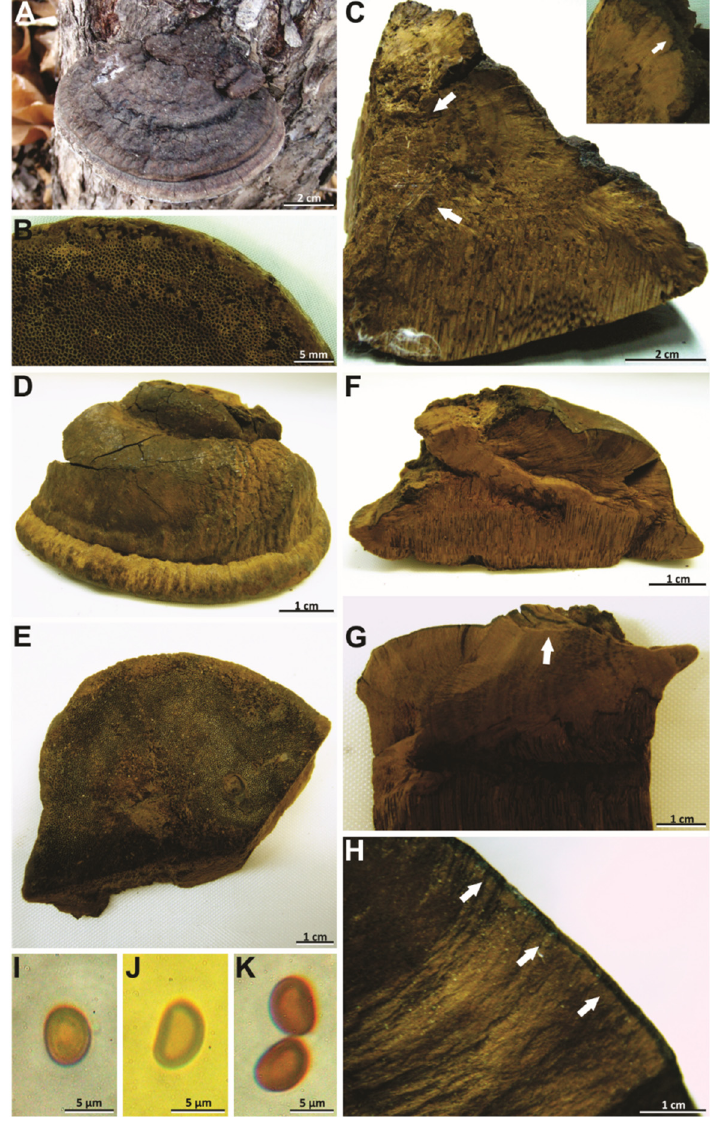
Figure 3. Morphological features of Phellinotus badius and P . magnoporatus . ( A – C ) P . magnoporatus (USM 250523, holotype). ( A ) basidioma; ( B ) pore surface; ( C ) perennial basidioma with detail of mycelial core in the context (the white arrows point to the cuticule and mycelial core in the context). ( D – K ) Phellinotus badius (K–M 199720, lectotype). ( D ) basidioma; ( E ) pore surface; ( F – H ) perennial basidioma with detail of a dark line in the context (the white arrows point to the dark line in the context); ( I – K ) basidiospores. ( I ) in water; ( J ) in Melzer’s reagent; ( K ) in KOH. Hyphal system monomitic in the context and dimitic in the tubes; context domi- nated by generative hyphae, (3–)4–5(–6.5) µ m diam, branched, thin-walled to gradually thick-walled, occasionally septate, trama of tubes with thin to slightly thick-walled gen- erative hyphae, simple septate, branched, and unbranched skeletal hyphae, thick-walled with a visible to solid lumen, (150–)170–479(–595) µ m long × (3.5–)4–5(–5.5) µ m diam (L avg. = 334.93 µ m, W avg. = 4.5 µ m), tapering to the apex where the wall is thin and three to four adventitious septa are present, setae absent, cystidioles absent, abundant quadran- gular or rhomboid crystals in the hymenium and trama of tubes, basidia not observed, basidiospores broadly ellipsoid to ellipsoid, with a flattened side, 6–7(–8) × (4.5–)5–6 µ m (L avg. = 7.2 µ m, W avg. = 5.3 µ m), Q = 1.25–1.50 (Q avg. = 1.36), thick-walled, smooth, pale brownish yellow in water, turning chestnut to ferruginous brown in KOH,